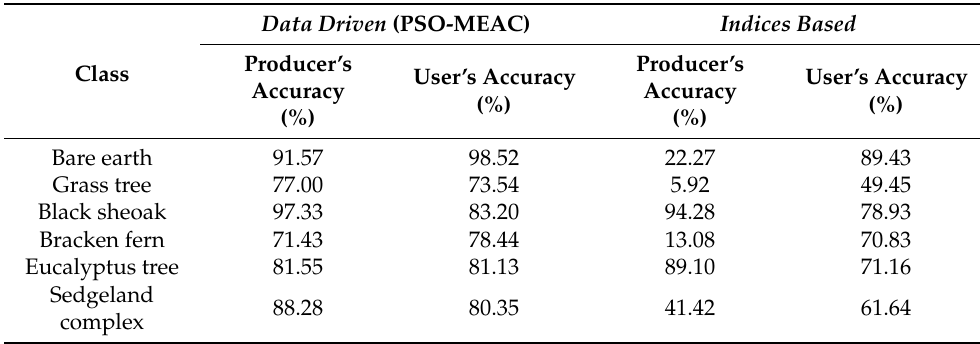
Table 1. Evaluation of classification accuracy achieved using the data-driven (PSO-MEAC) method against indices based band